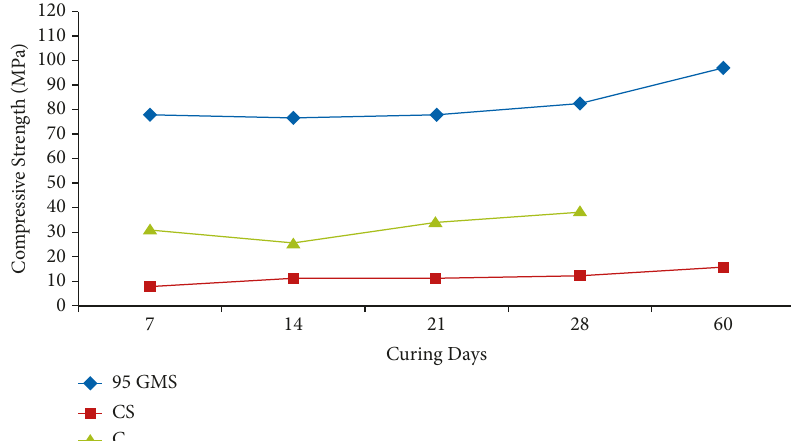
Figure 8: Compressive strength results for optimal mixture design and OPC reference mixtures during 7, 14, 21, 28 and 60 curing days.